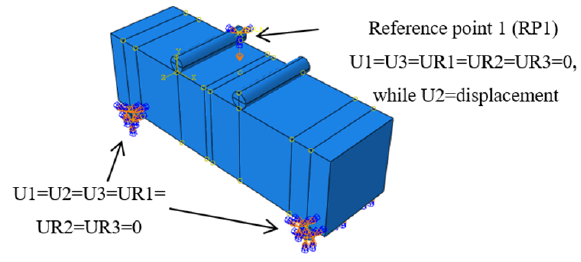
Fig. 8. Boundary conditions for the model of the beam.